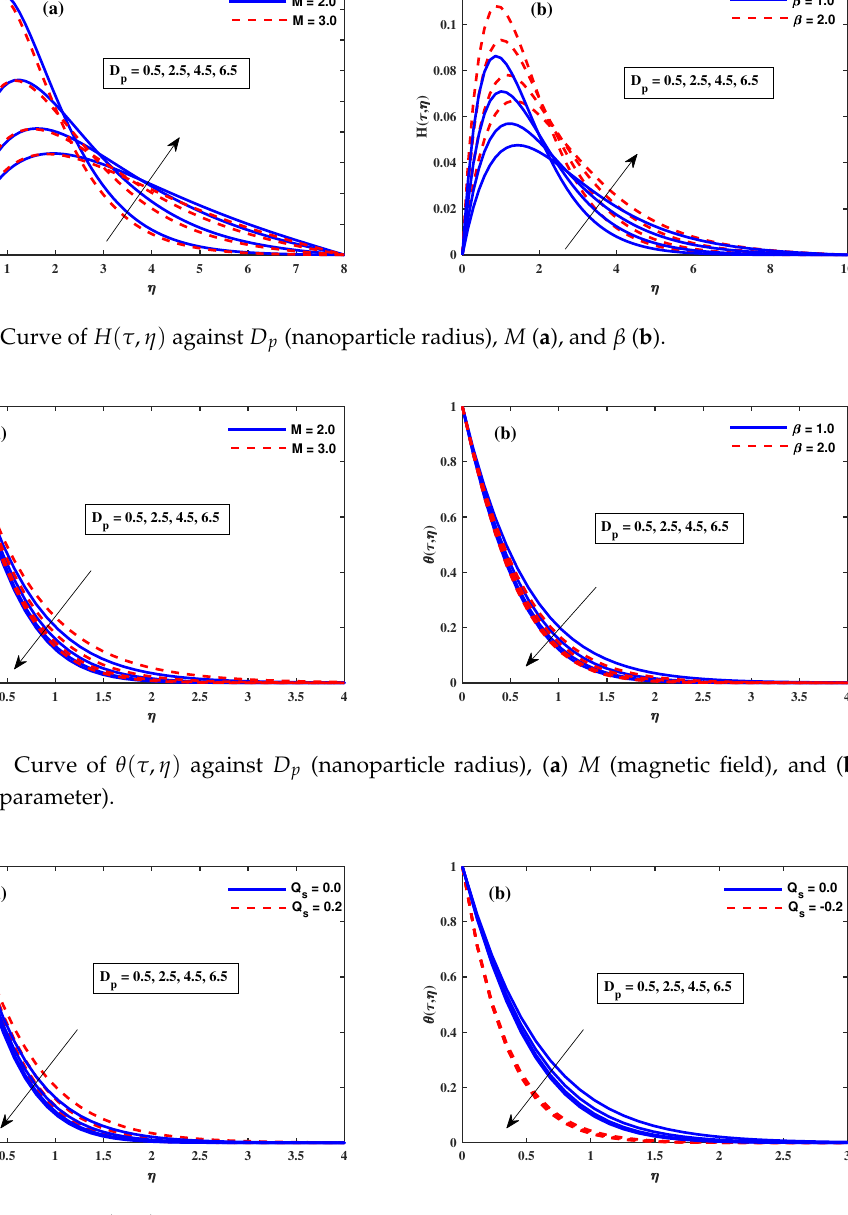
Figure 5. Curve of θ ( τ , η ) against ( a ) D p (nanoparticle radius) and ( b ) Q s (Heat